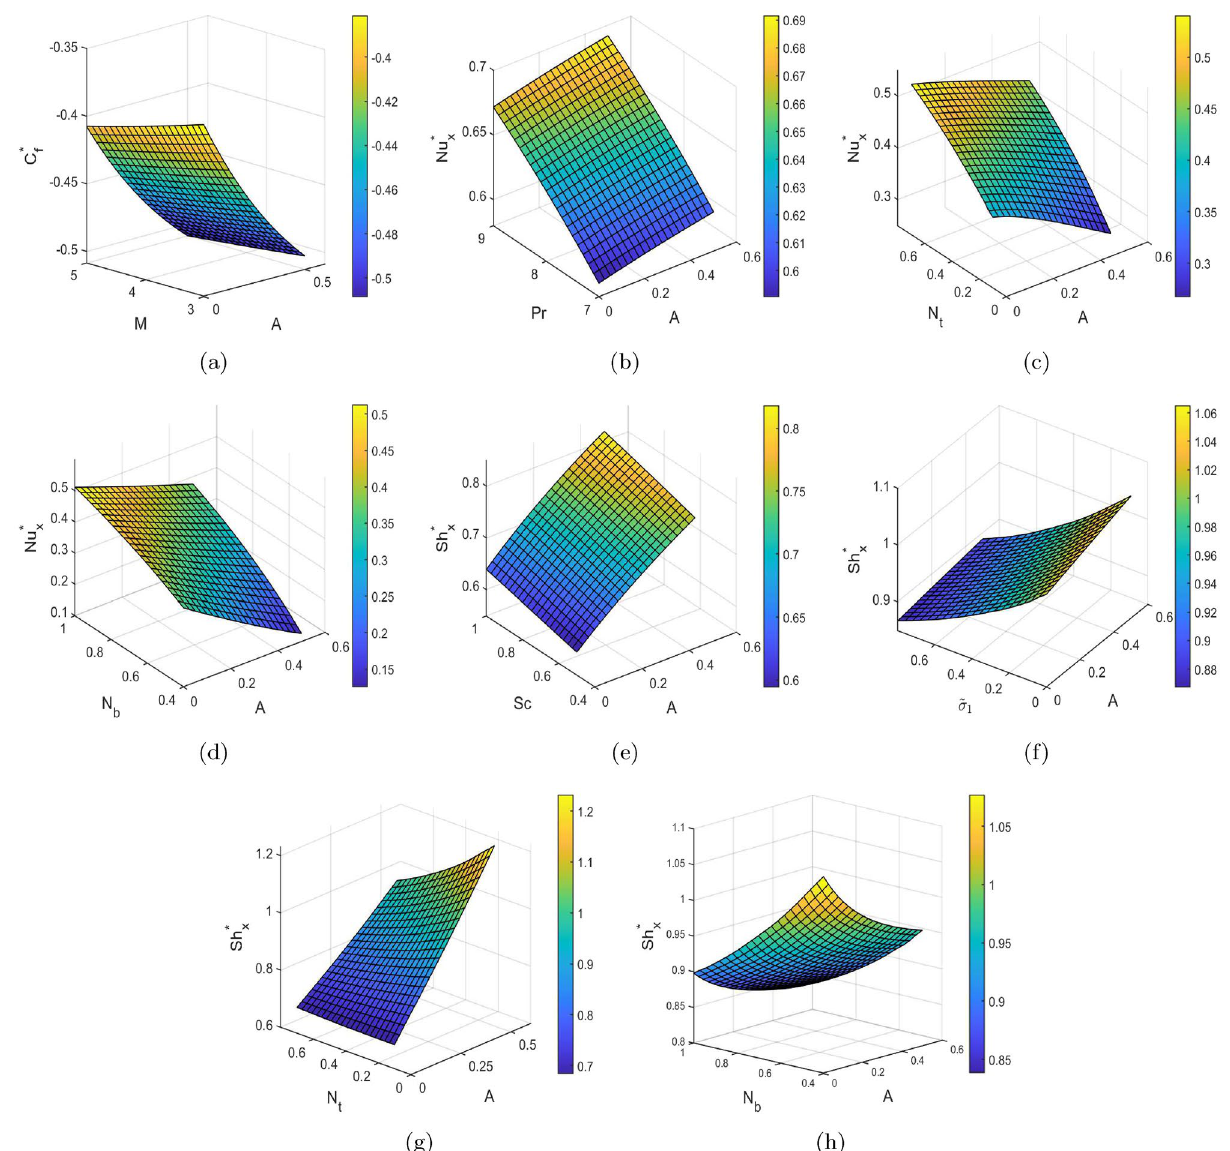
Figure 8. ( a ) C ∗ f versus M and A, ( b ) Nu ∗ x versus Pr and A, ( c ) Nu ∗ x versus N t and A, ( d ) Nu ∗ x versus N b and A, ( e ) Sh ∗ x versus Sc and A, ( f ) Sh ∗ x versus ˜ σ 1 and A, ( g ) Sh ∗ x versus N t and A, and ( h ) Sh ∗ x versus N b and